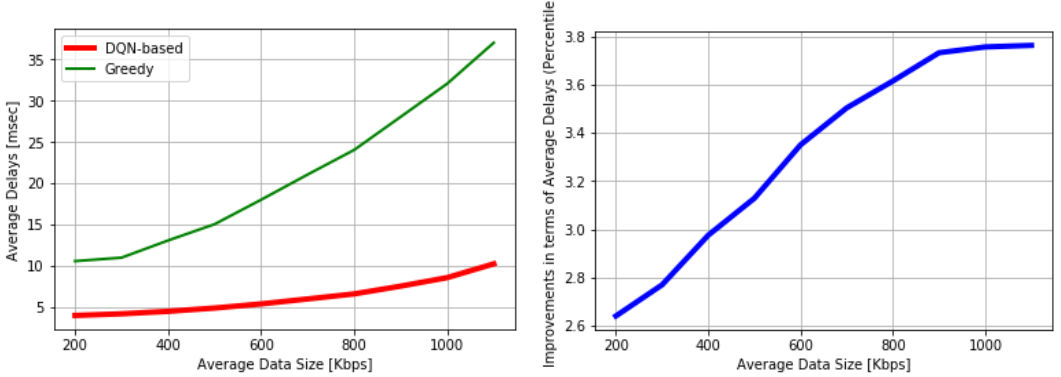
Figure 7. Performance evaluation results (Proposed DQN-based vs. Greedy): Average delays ( left ) and performance gap ( right